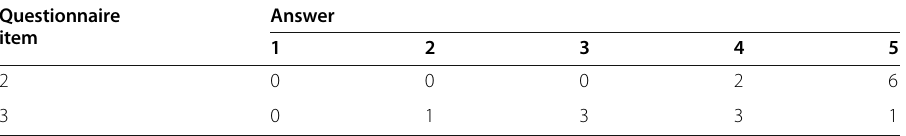
Table 8 The number of participants for each answers in the questionnaire items 2 and 3 Questionnaire